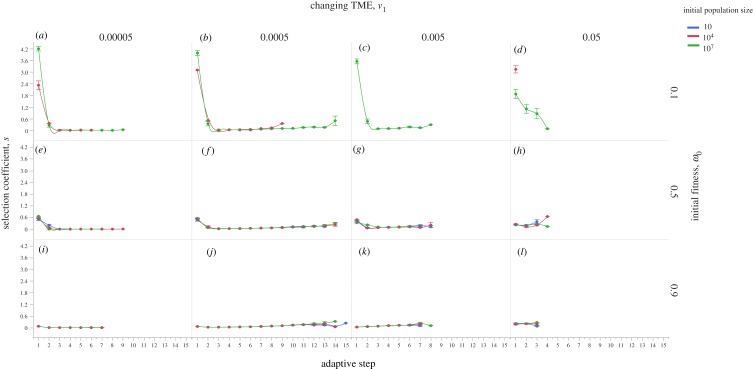
Cancer adaptive evolution under multiple different initial conditions. Simulations are performed with different initial conditions regarding population size, fitness and TME optimum change rates. Three conditions for initial population size are used, n = 10 (coloured blue), n = 104 (coloured red) and n = 107 (coloured green), respectively. Three conditions for initial fitness are also used, w = 0.1 (a–d), w = 0.5 (e–h) and w = 0.9 (i–l). Populations also evolve under four different TME optimum change rates: v1 = 5 × 10−5 (a,e,i), v1 = 5 × 10−4 (b,f,j), v1 = 5 × 10−3 (c,g,k) and v1 = 0.05 (d,h,l), respectively. Error bars are s.e.m. and each point represents 100 independent simulations. Note that in (e–l), all colour lines are present, but they are too close to each other to be seen clearly.